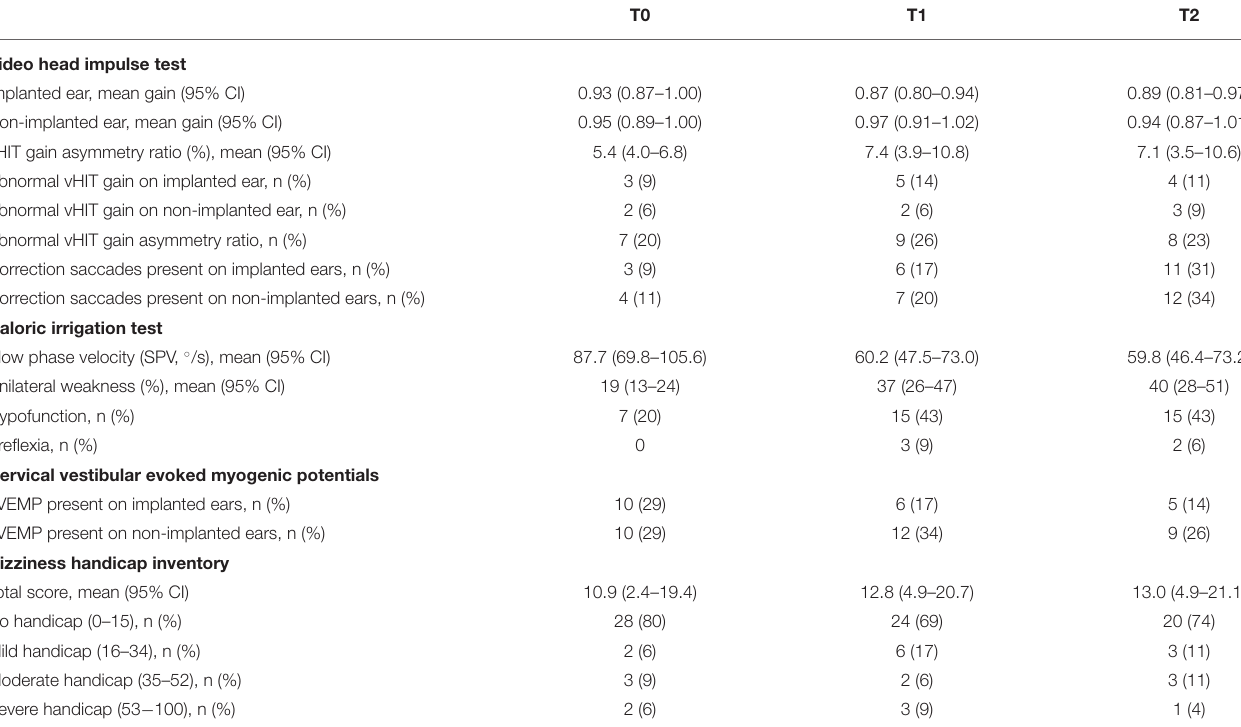
TABLE 3 | Summary data of vestibular test battery results at baseline before implantation (T0), first postoperative follow-up (T1), and second postoperative follow-up (T2). T0 T1 T2 Video head impulse